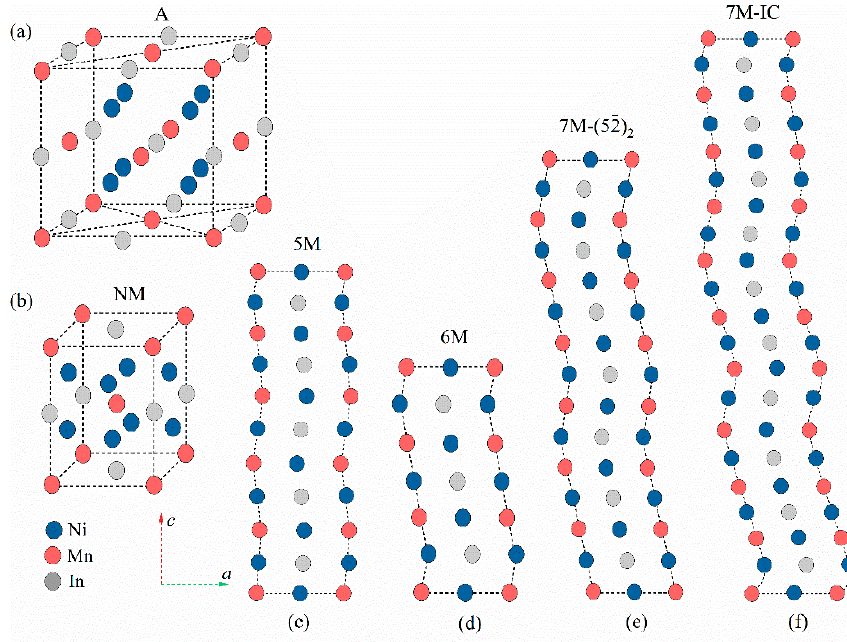
Figure 1. Crystal structures of ( a ) cubic austenite, ( b ) NM martensite, ( c ) 5M martensite, ( d ) 6M martensite, ( e ) 7M (52) − martensite, and ( f ) 7M–IC martensite for Ni 2 MnIn alloy. martensite, ( e ) 7M − ( 52 ) martensite, and ( f ) 7M–IC martensite for Ni 2 MnIn 2 2